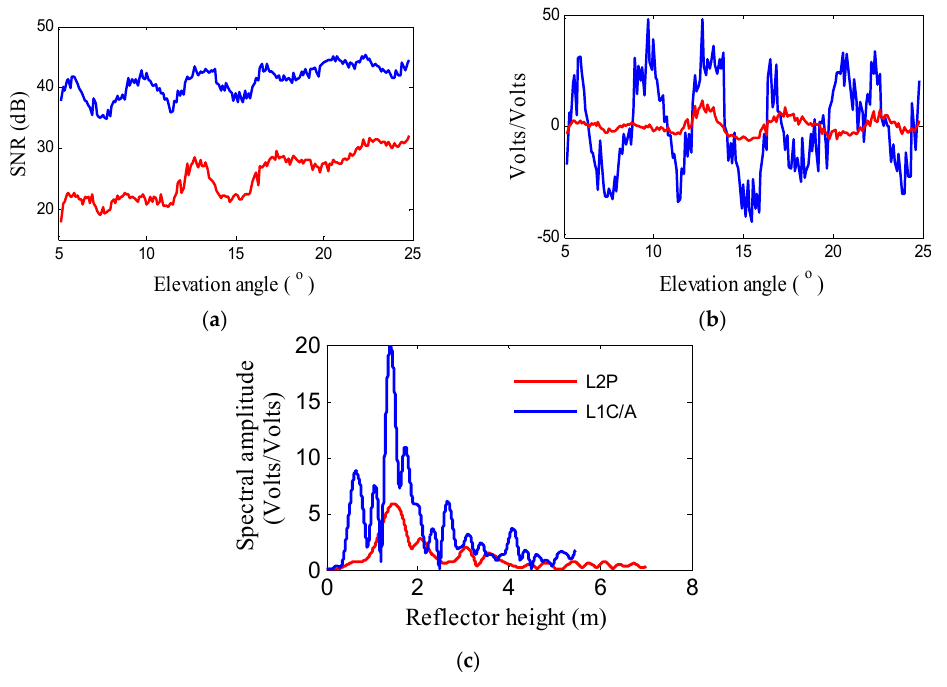
Figure 5. Comparison of L1C/A and L2P SNR data, multipath modulations and Lomb–Scargle periodogram of multipath pattern at AB33. ( a ) L1C/A and L2P SNR from satellite PRN10; ( b ) Multipath modulations; ( c ) Lomb–Scargle periodogram of multipath pattern.